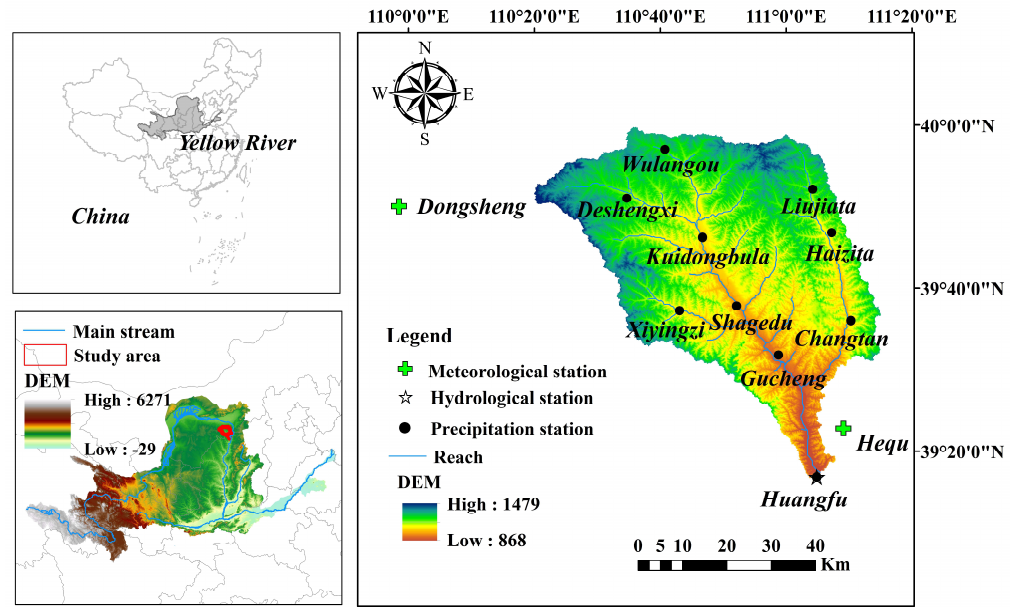
Figure 1. Locations of the Huangfuchuan Watershed and hydro-meteorological stations.